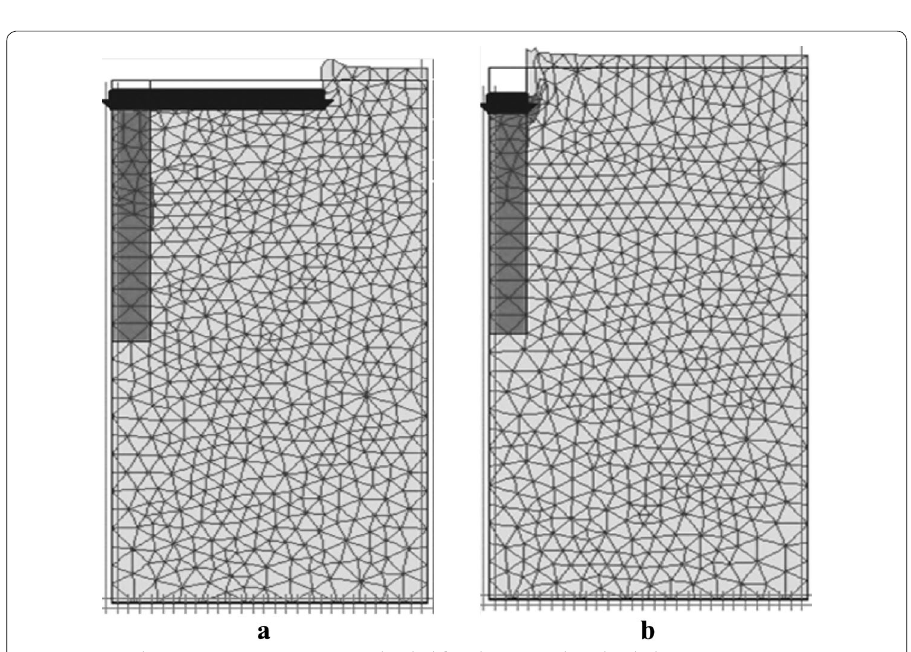
Fig. 9 FM mesh (axisymmetric) a entire area loaded, b column area lone